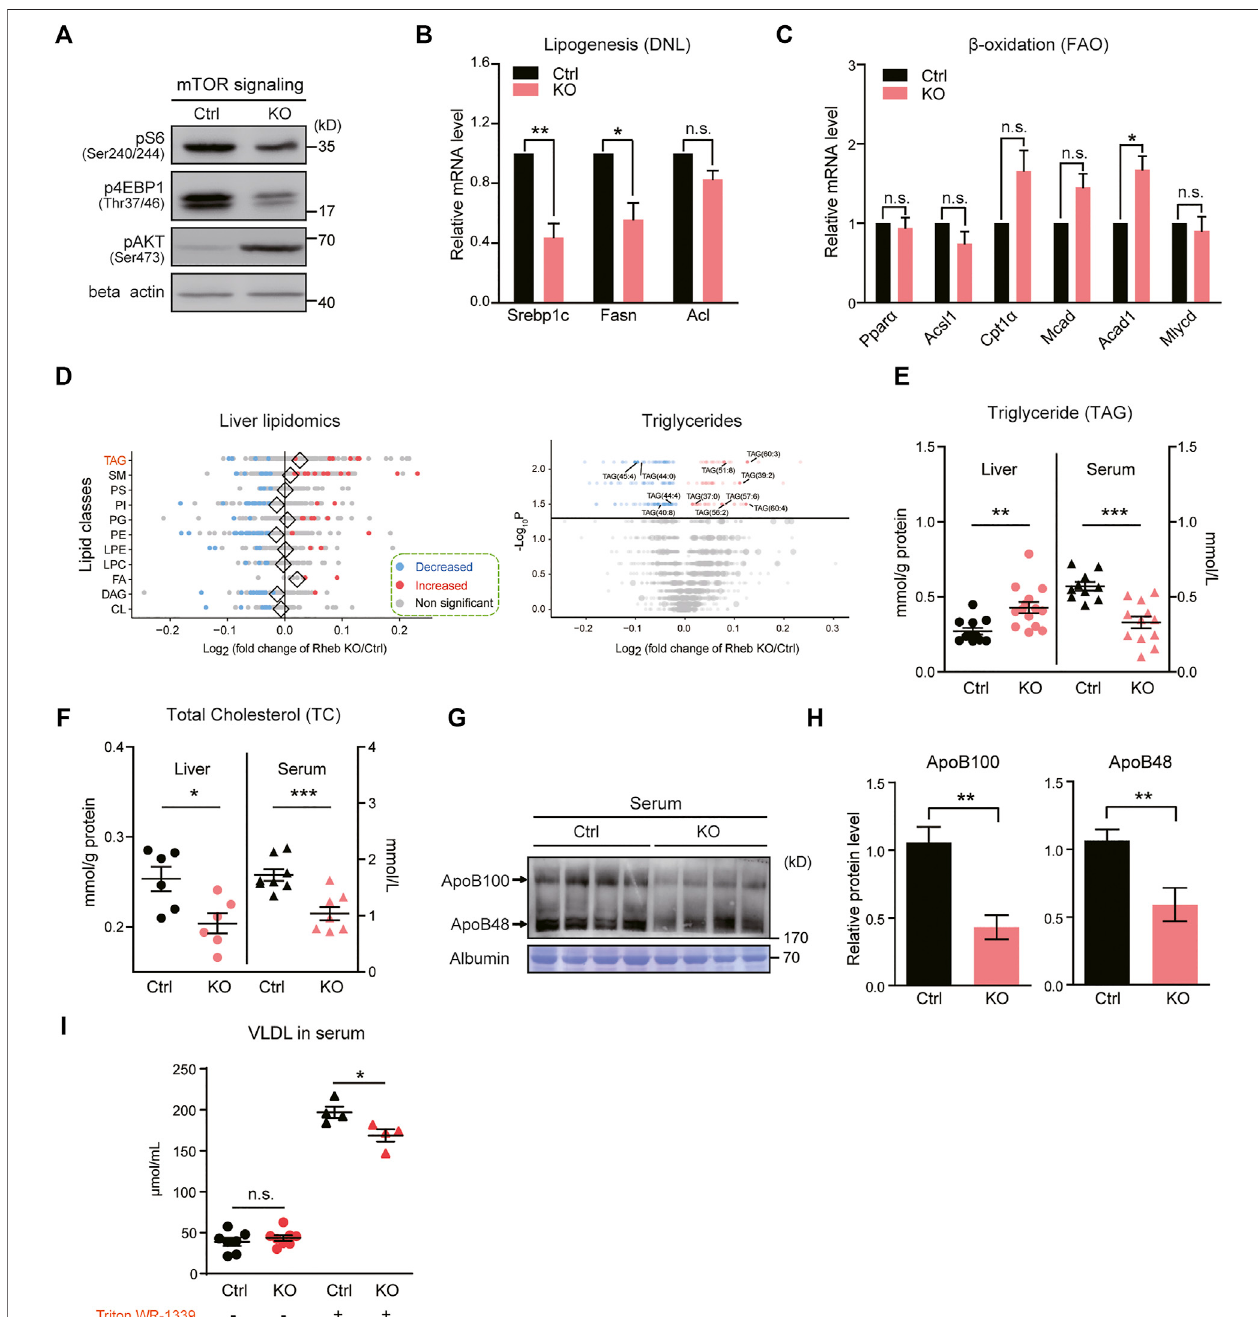
FIGURE2| Hepatic Rheb KOimpairstriglyceridesecretionintheliver. (A) WesternblotsofmTORC1activityintheliverof Rheb KOmice. (B) QuantitativeRT – qPCR detection of lipogenic genes levels in the liver of Rheb KO mice ( n = 4). (C) mRNA levels of fatty acid oxidation genes unchanged in the liver of Rheb KO mice ( n = 4). (D) Forestplotshowingthelogfoldchangesoflipidsintheliverof Rheb KOmiceovercontrols.Redandbluepointsrepresentsigni fi cantlyincreasedanddecreasedlipidsof each lipid class in the liver of Rheb KO mice. Diamonds indicate the average log fold change of lipids in each lipid class. Shown here are selected lipid classes. Volcano plot showing log fold changes and signi fi cant difference of identi fi ed lipids in the liver of Rheb KO mice. Total number of differential lipids is shown in the guide. Triglycerides are represented by larger points and signi fi cantly different triglycerides are annotated. (E) Scatter diagram showing an increased liver triglyceride level and decreased serum triglyceride level of Rheb KO mice (liver: n =12,serum: n = 10). (F) Scatterdiagramshowingdecreasedliver and serum total cholesterol levels of Rheb KOmice. (G,H) Westernblots (G) andquanti fi cations (H) showingthedecreasedserumApoB100andApoB48levelsof Rheb KOmice( n =4,normalizedagainstserum Albumin). (I) DiagramsshowingthedecreasedVLDLlevelsintheserumof Rheb KOmice( n =4).Datarepresentmean±SEM. *p < 0.05, **p < 0.01, ***p < 0.001.n.s.no statistical signi fi cance.